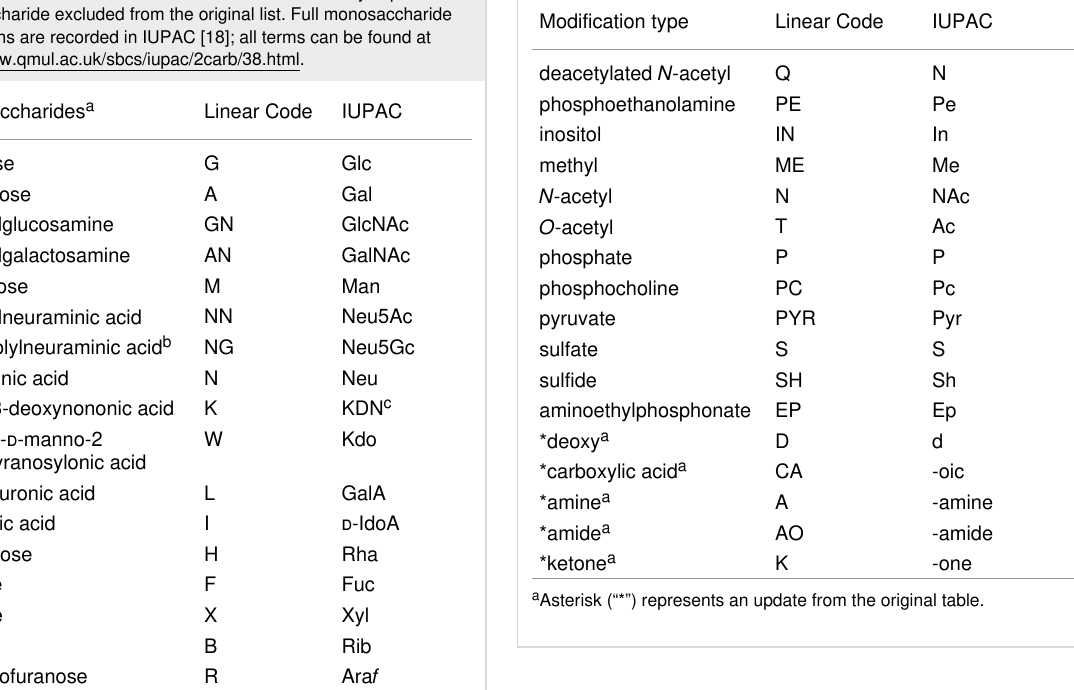
Table 5: Common modifications and their Linear Code (from [31]).